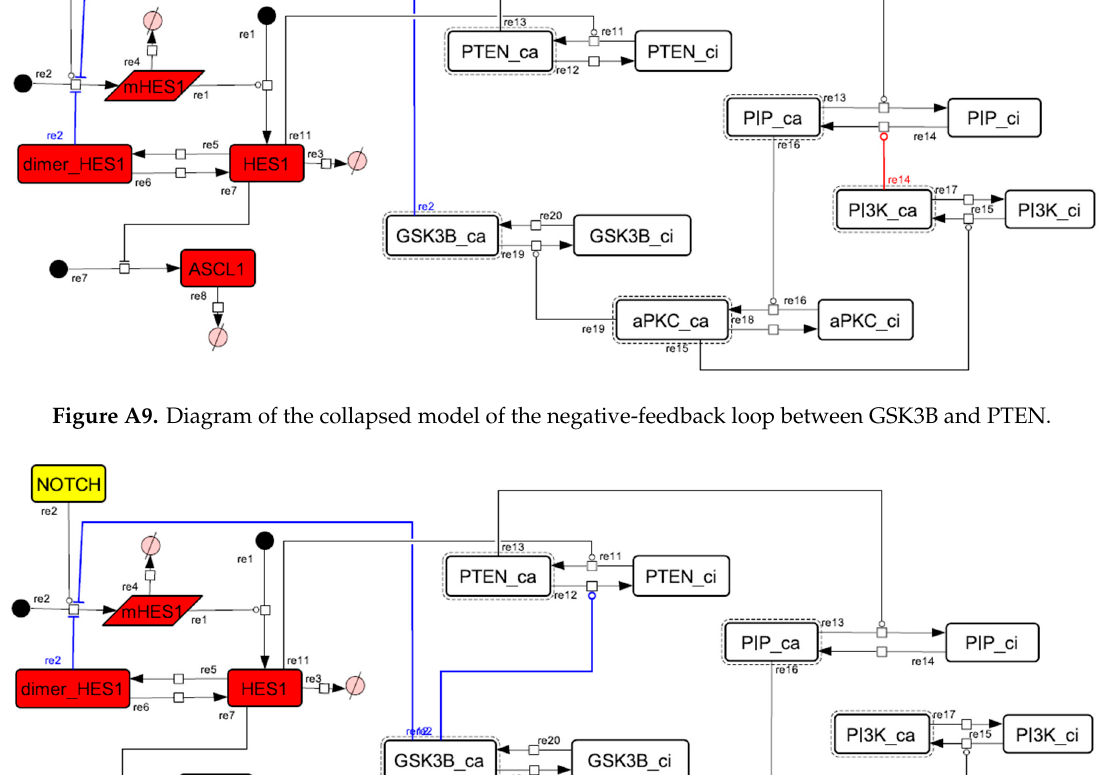
Figure A8. Diagram of the collapsed model of the HES1 self ‐ feedback loop.